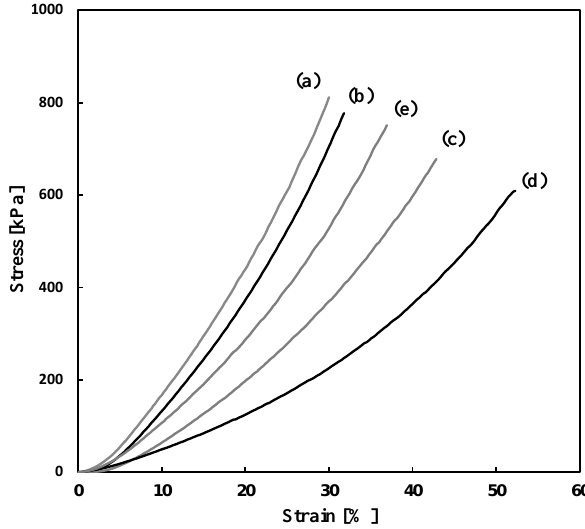
Figure 4. Stress–strain curves of PEI-PEGDA400 gels: ( a ) Case 1 and ( b ) Case 2, DETA-PEGDA400 gels: ( c ) Case 1 and ( d ) Case 2, and PEI-PEGDA400 gels: ( e ) Case 1; solvent: DMSO, monomer concentration: 30 wt%. Table 2. Gel formation time and mechanical properties of PEI or DETA-polyethylene glycol diacrylate (PEGDA) gels, solvent: DMSO, monomer concentration: 30 wt%.